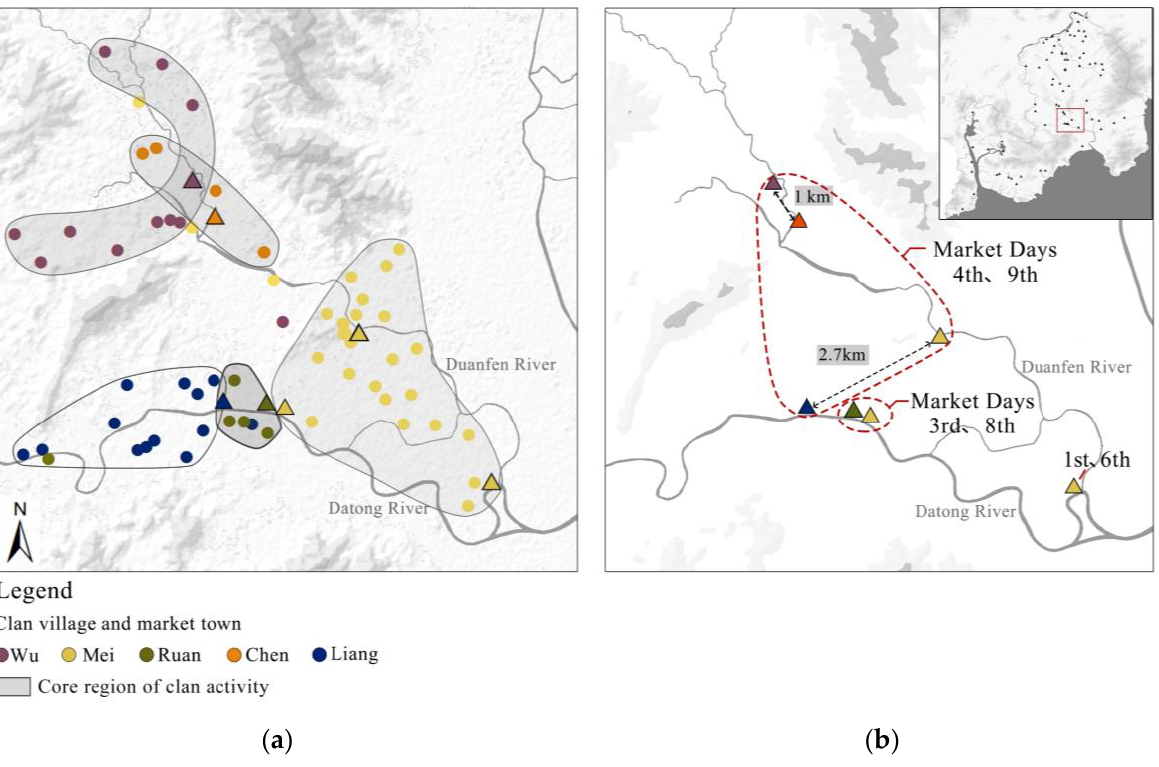
Figure 5. Diagram of the region between the Duanfen River and the Datong River. The different color triangles represent different clan market towns, and the different color dots represent different clan villages. ( a ) Illustrates the density of the different clans' territories; ( b ) Illustrates the close proximity of different clans' markets and the conflicting market days. Table 5. Summary of the market days of market towns in the region between the Duanfen River and the Datong River.